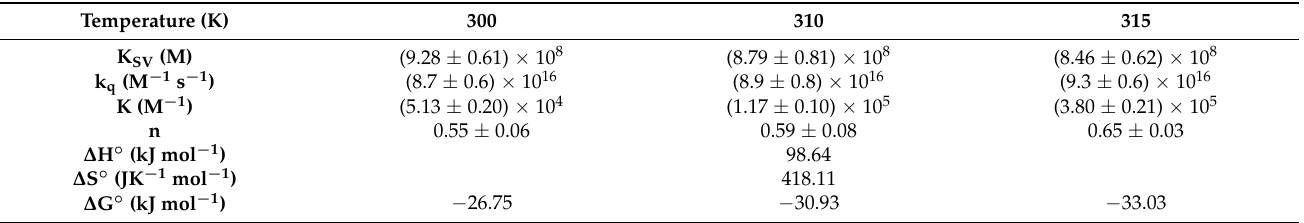
Table 2. The Stern–Volmer quenching constants, K sv , bimolecular quenching rate constants, k q , and the binding parameters for the interaction of AgNPs with BSA at the different